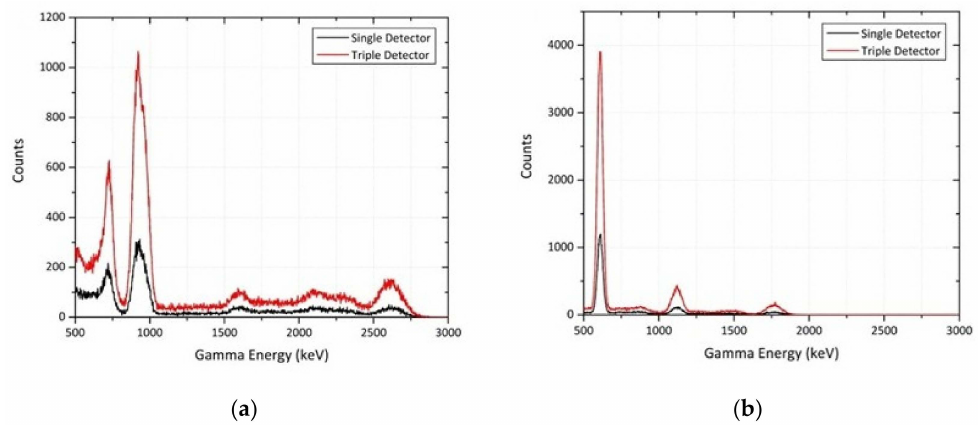
Figure 8. Gamma spectra obtained using a single and triple CsI(Na) detector setup for: ( a ) 232 Th point source; ( b ) 238 U point